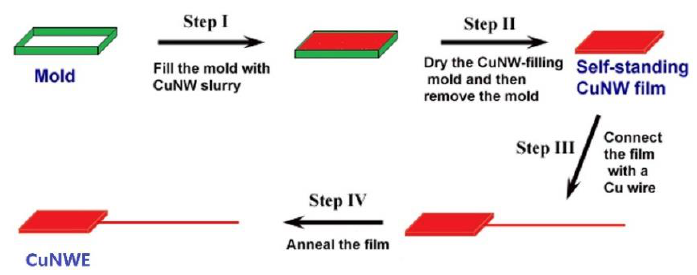
Figure 10. Schematic illustration for preparation of CuNWE